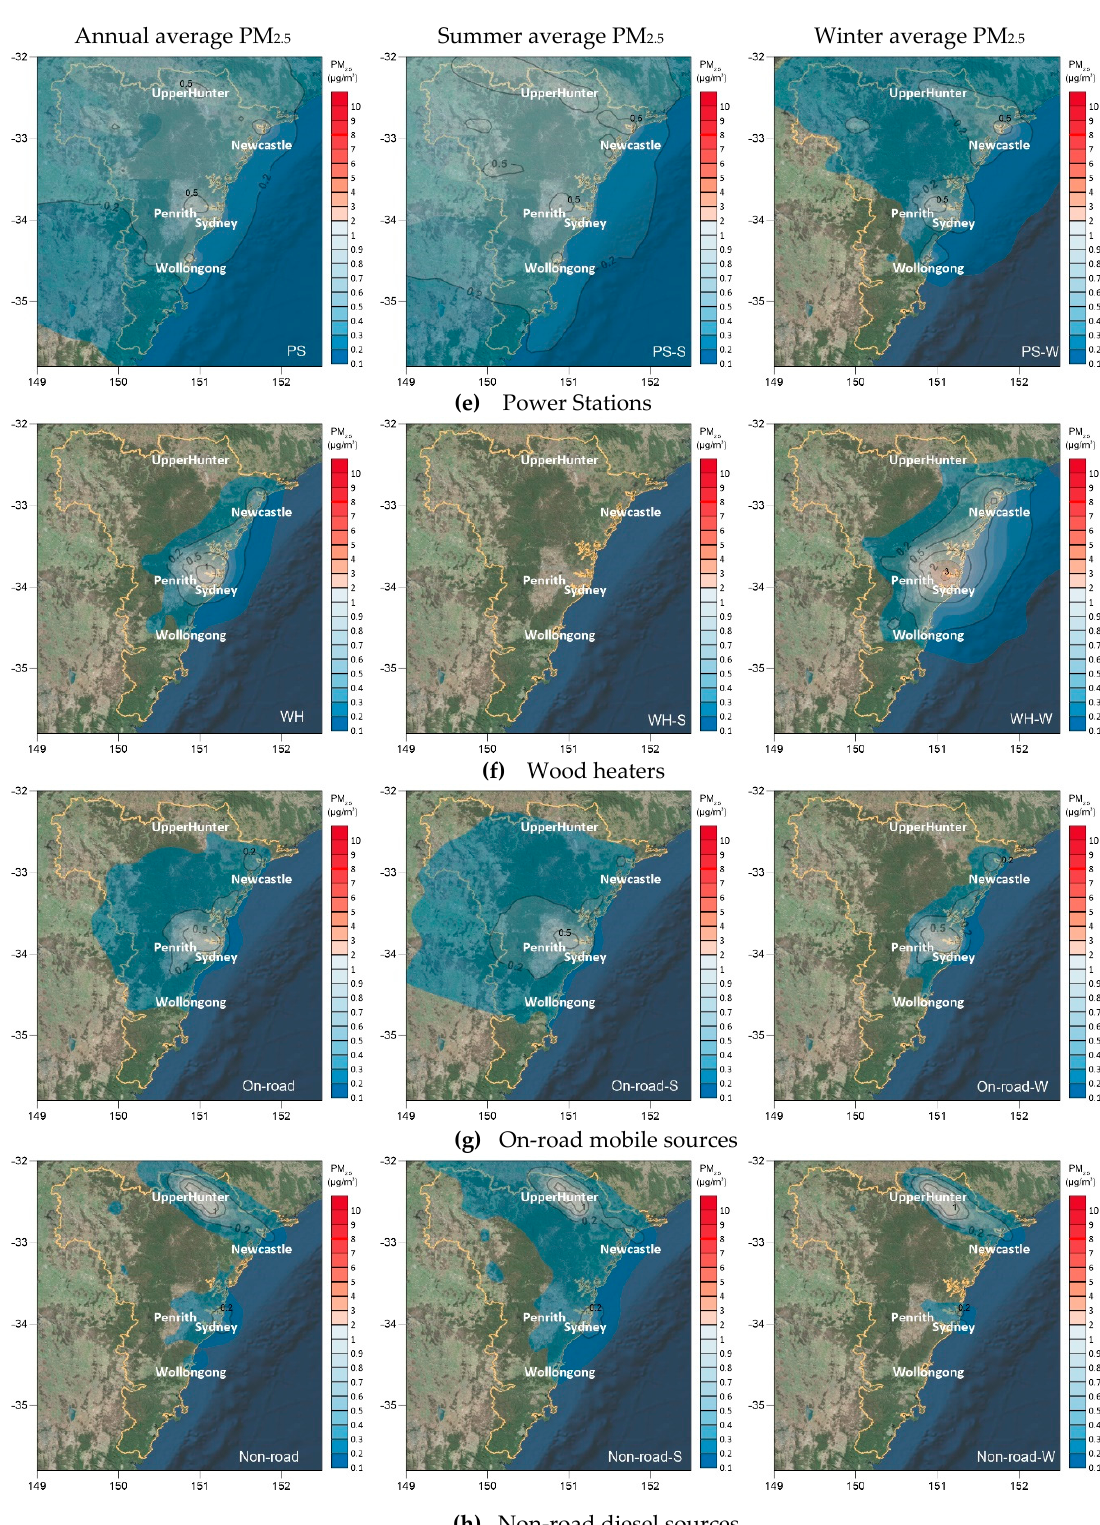
Figure 4. Average PM 2.5 concentrations ( µ g/m 3 ) in calendar year for 2008, summer (DJF) and winter (JJA) predicted by CCAM-CTM under different modelling scenarios: ( a ) base case, ( b ) natural sources,